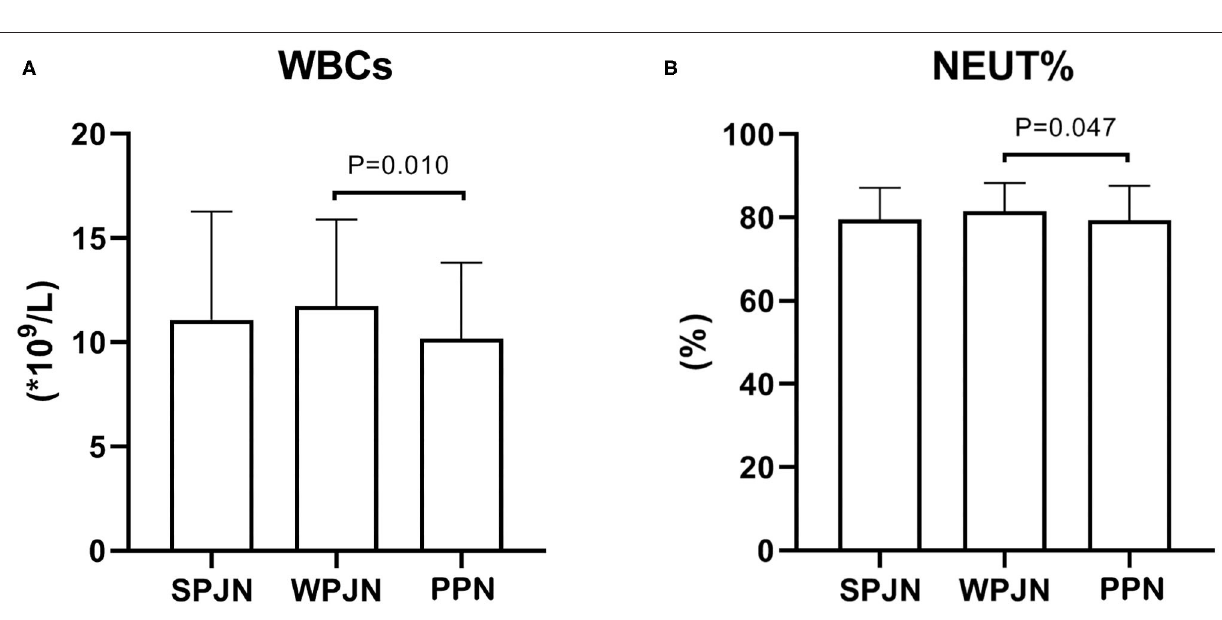
Frontiers in Nutrition |